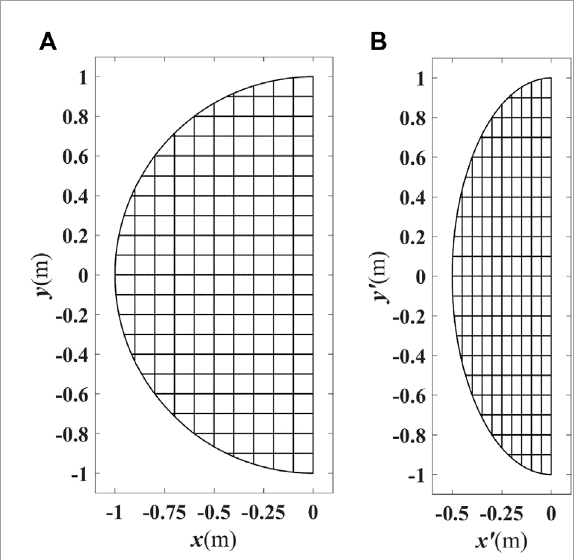
FIGURE 2 Schematic of the underlying transformation between (A) the half circle with radius of one and (B) a half ellipse with semi-minor axis of δ = 0 . 5 and semi-major axis of one. The x -constant and y -constant lines in virtual space are plotted as well as their mapped version in physical